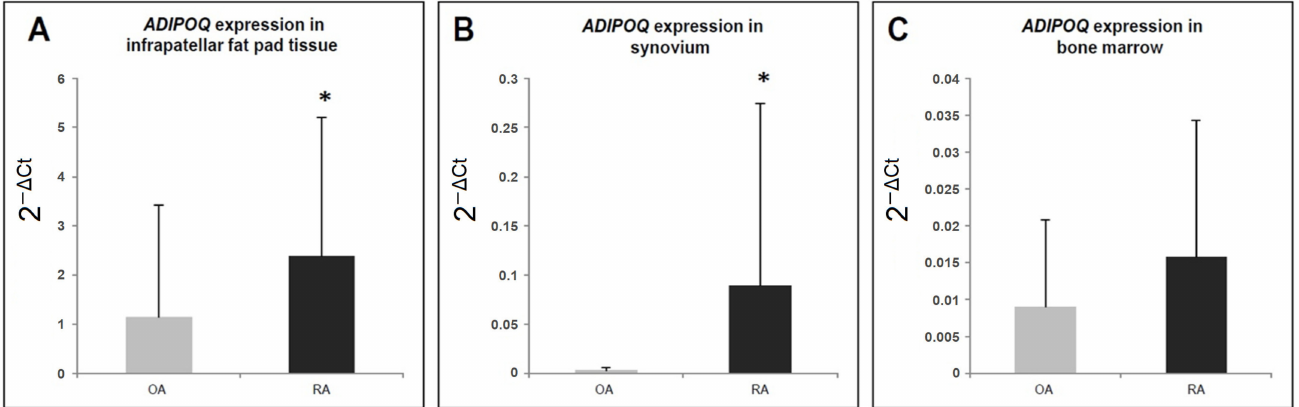
Figure 2. mRNA expression levels of adiponectin ( ADIPOQ ) in OA—osteoarthritis and RA—rheumatoid arthritis patients (mean ± SD): Panel ( A ) infrapatellar fat pad tissue, Panel ( B ) syn- ovium, Panel ( C ) bone marrow. * p < 0.05 indicates a significant increase in gene expression in RA patients as compared to OA patients (Mann–Whitney test).